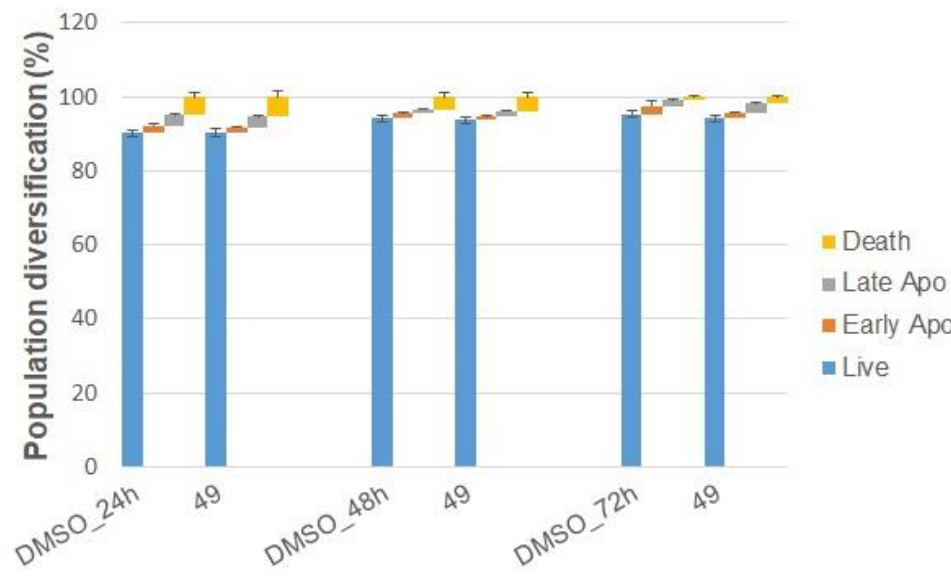
Figure 3. Effect of 49 on the apoptosis of A549 cells after 24, 48 and 72 h incubation. The data show the mean ± SD values of three independent experiments.